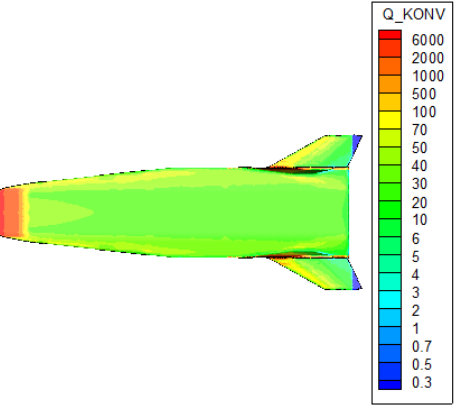
Figure 3. Convective flux q w (kW/m 2 ) distribution for X-33 upper part, Mach number M = 6, height H = 25 km, attack angle α = 10 ◦ .